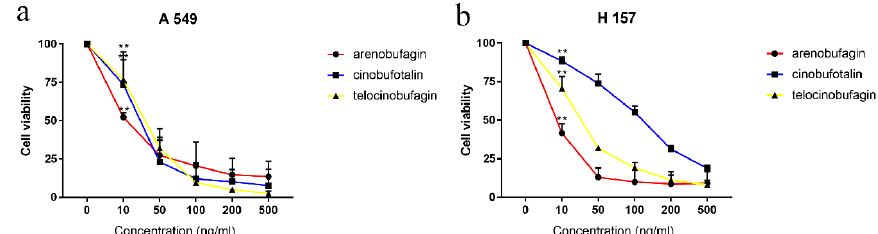
Figure 7. The inhibitory effects of arenobufagin, telocinobufagin, and cinobufotalin on A549 cells ( a ) and H157 cells ( b ) analyzed by 3 ‐ (4, 5 ‐ dimethylthiazol ‐ 2 ‐ yl) ‐ 2, 5 ‐ diphenyltetrazolium bromide (MTT) assay. ** Indicates statistical significance ( p < 0.01). Table 9. The inhibitory effects of bufadienolides on A549, H157